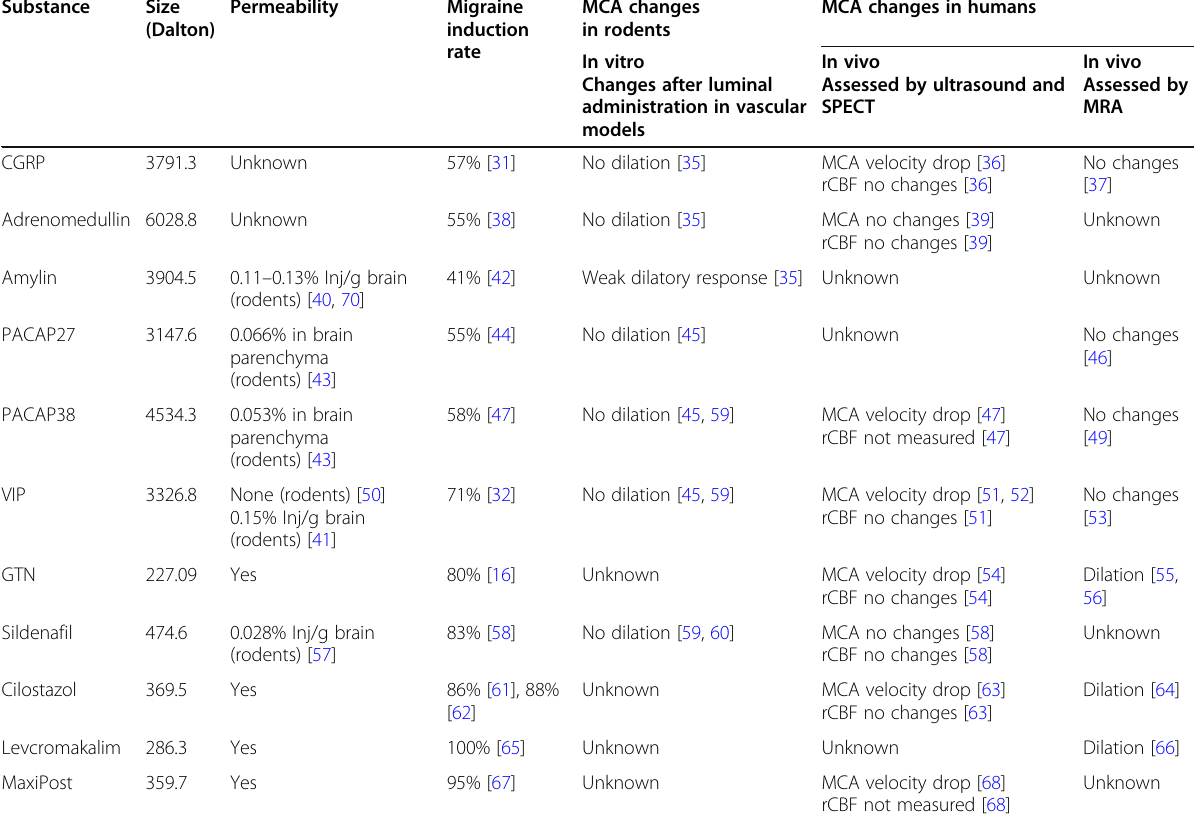
Table 3 Brain Barrier Permeability of Migraine-Inducing Substances